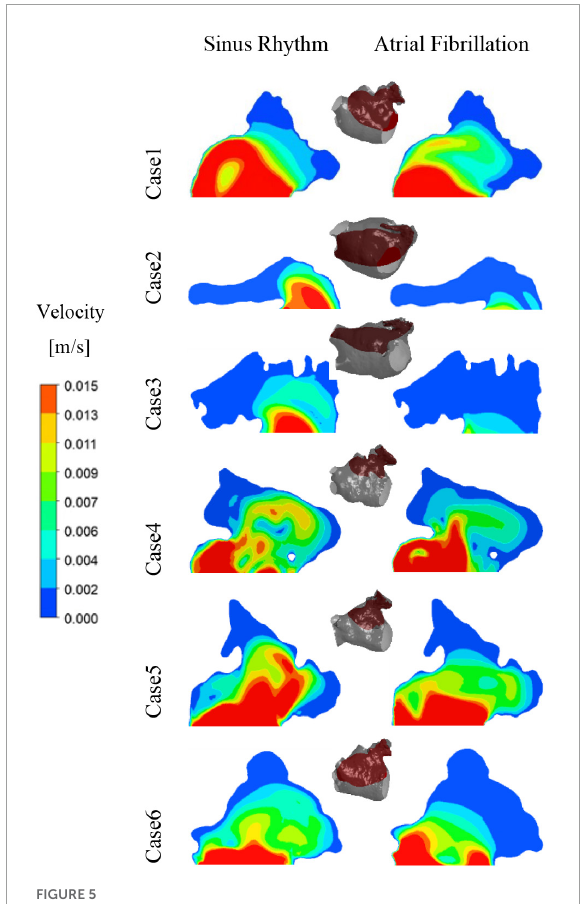
FIGURE5 The velocity distribution of a section at LAA at t = 9.9T.